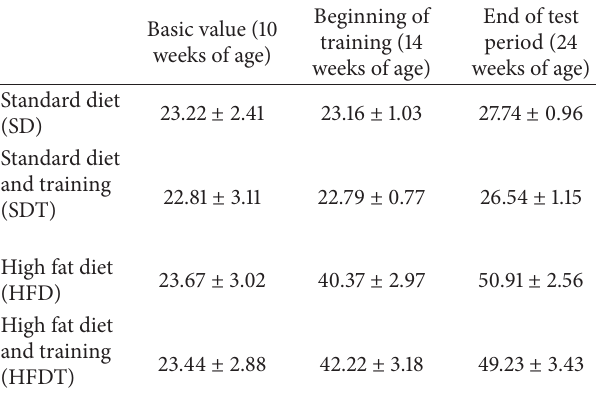
Figure 2: Glucose tolerance test: average of blood glucose con- centrations in mg/dL after intraperitoneal application of glucose solution. Blood glucose levels were determined 0, 30, 60, and 120 minutes after application. Glucose tolerance is inversely related to insulin resistance. SD standard diet group ( 𝑛 = 10 ), SDT standard diet and training group ( 𝑛 = 10 ), HFD: high-fat-diet group ( 𝑛 = 10 ), HFDT: high-fat-diet and training group ( 𝑛 = 10 ).